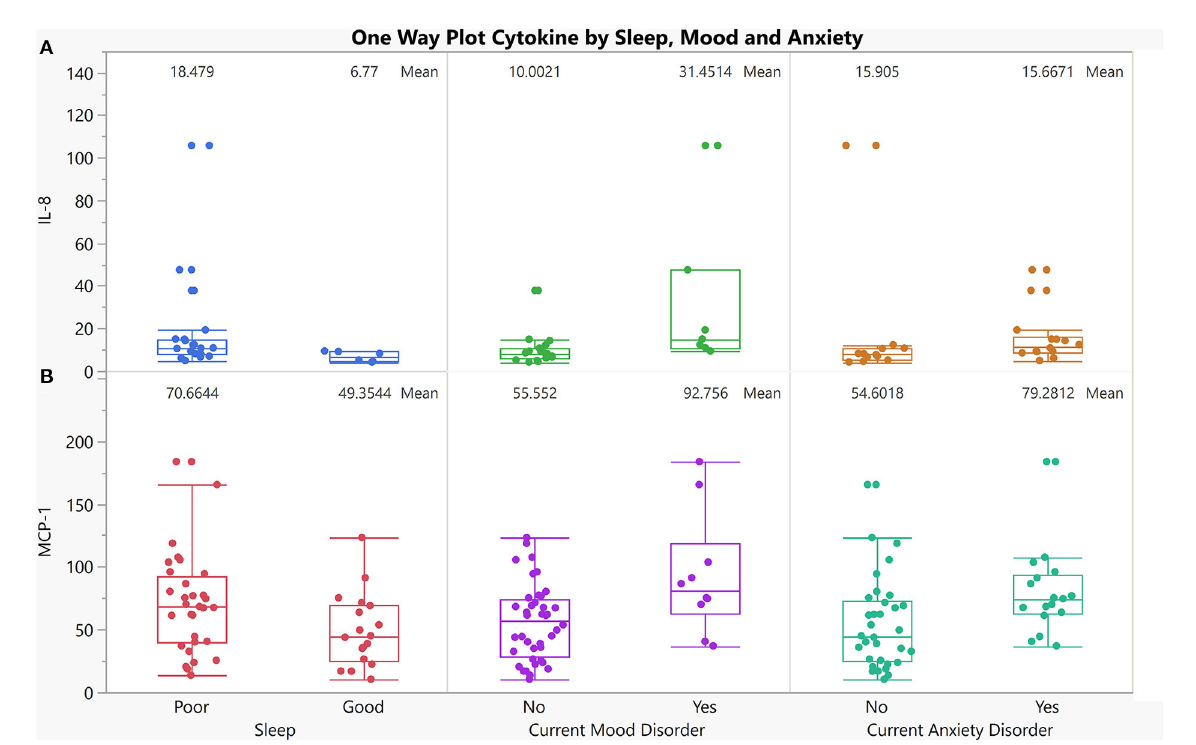
FIGURE5 One-way plot of IL-8, and MCP-1 vs. co-occurring dichotomized symptoms in AUD. X-axis indicates 3 dichotomized symptoms in individuals with AUD who reported having good sleep and those who reported having poor sleep (first panel), individuals with AUD who currently have a mood disorder compared to those who currently do not have a mood disorder (2nd panel), individuals with AUD who currently have an anxiety Disorder compared to those who currently do not have an anxiety disorder (3rd panel). Y-axis is cytokine levels of: (A) IL-8 ( p = 0.02, p = 0.003, p = 0.04 respectively for sleep, mood and anxiety), (B) MCP-1 levels ( p = 0.05, p = 0.01, p = 0.01 respectively for sleep, mood and anxiety).